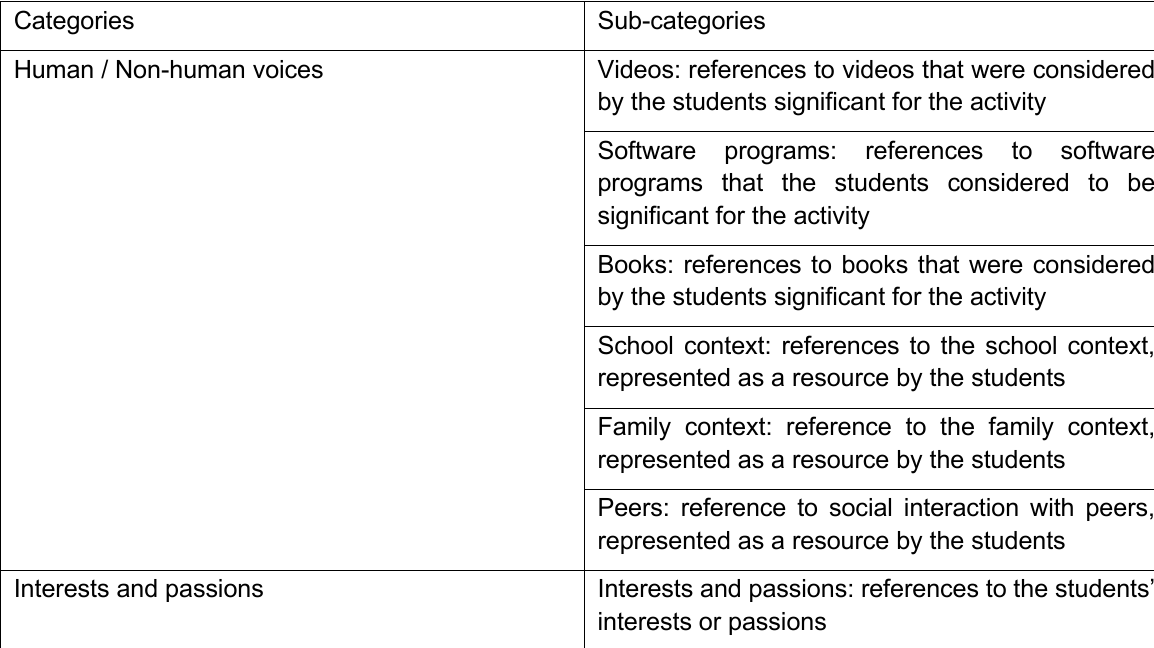
Table 1: the categories emerged from the